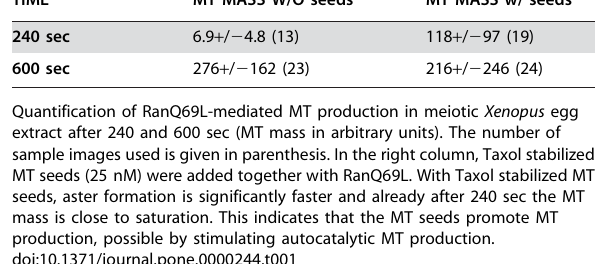
Table 1. MT production during aster formation around Taxol